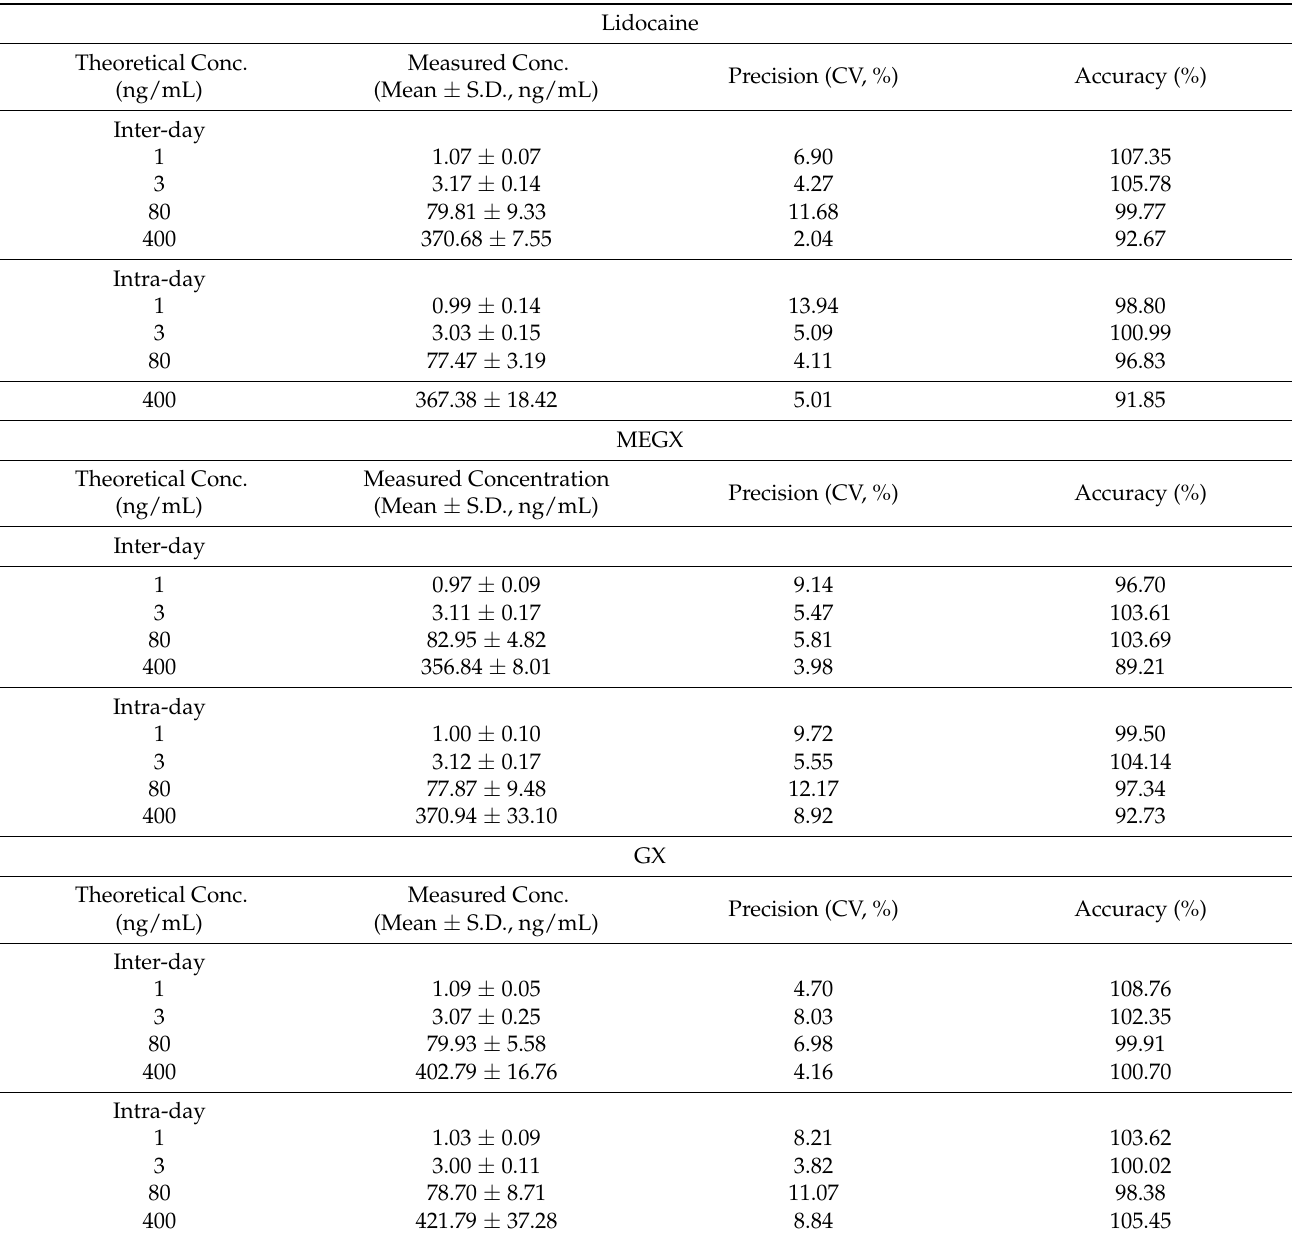
Table 1. Accuracy and precision for detection of lidocaine, monoethylglycylxylidide (MEGX), and glycylxylidide (GX).